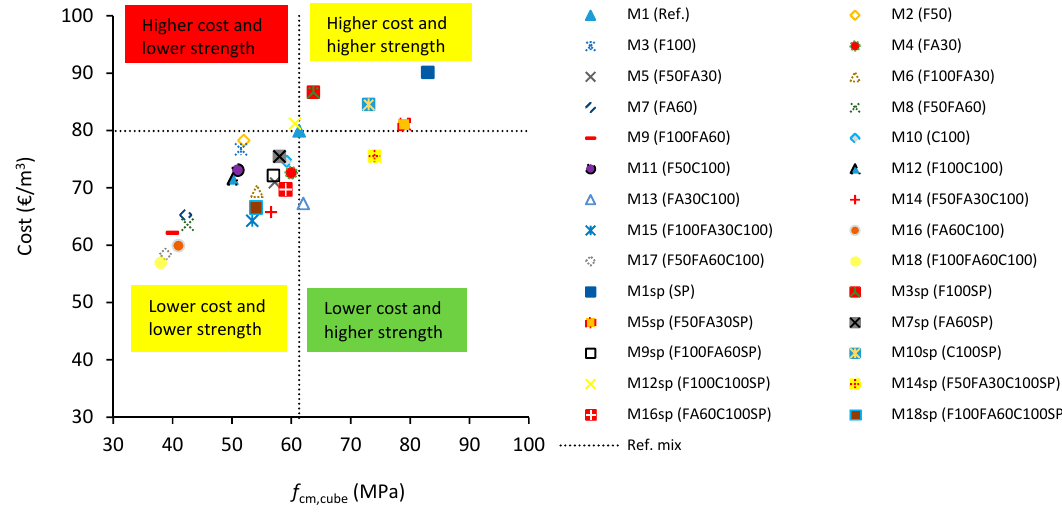
Figure 7. Relationship between compressive strength at 365 days and cost of 1 m 3 of concrete. The mixes are divided into four zones according to the cost and strength of reference concrete (M1).